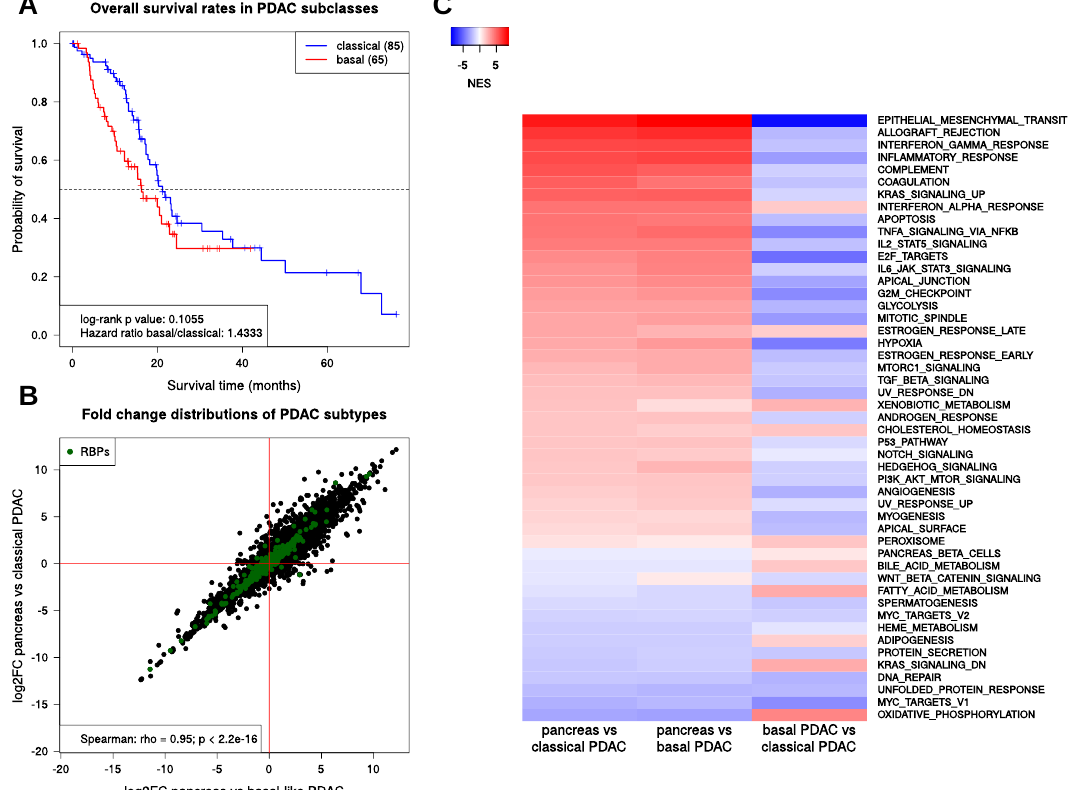
Figure 2. PDAC subtype properties. ( A ) Kaplan–Meier-curves showing overall survival rates for classical (blue) and basal-like (red) PDAC. ( B ) RNA expression changes of protein-coding genes in classical and basal-like PDAC subtypes compared to normal pancreas samples. Green points mark RNA binding proteins (RBPs). ( C ) Heatmap showing normalized enrichment scores (NES) obtained from gene set enrichment analyses (GSEA) of the 50 MSigDB hallmark gene sets using fold changes obtained by the comparisons of pancreas against classical PDAC (first column), pancreas against basal-like PDAC (second column), and basal-like against classical PDAC (third